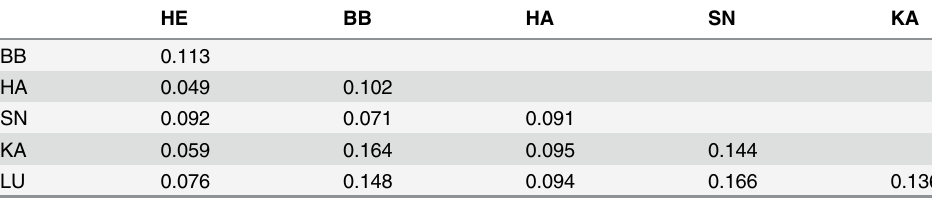
All values were signi fi cant ( P <